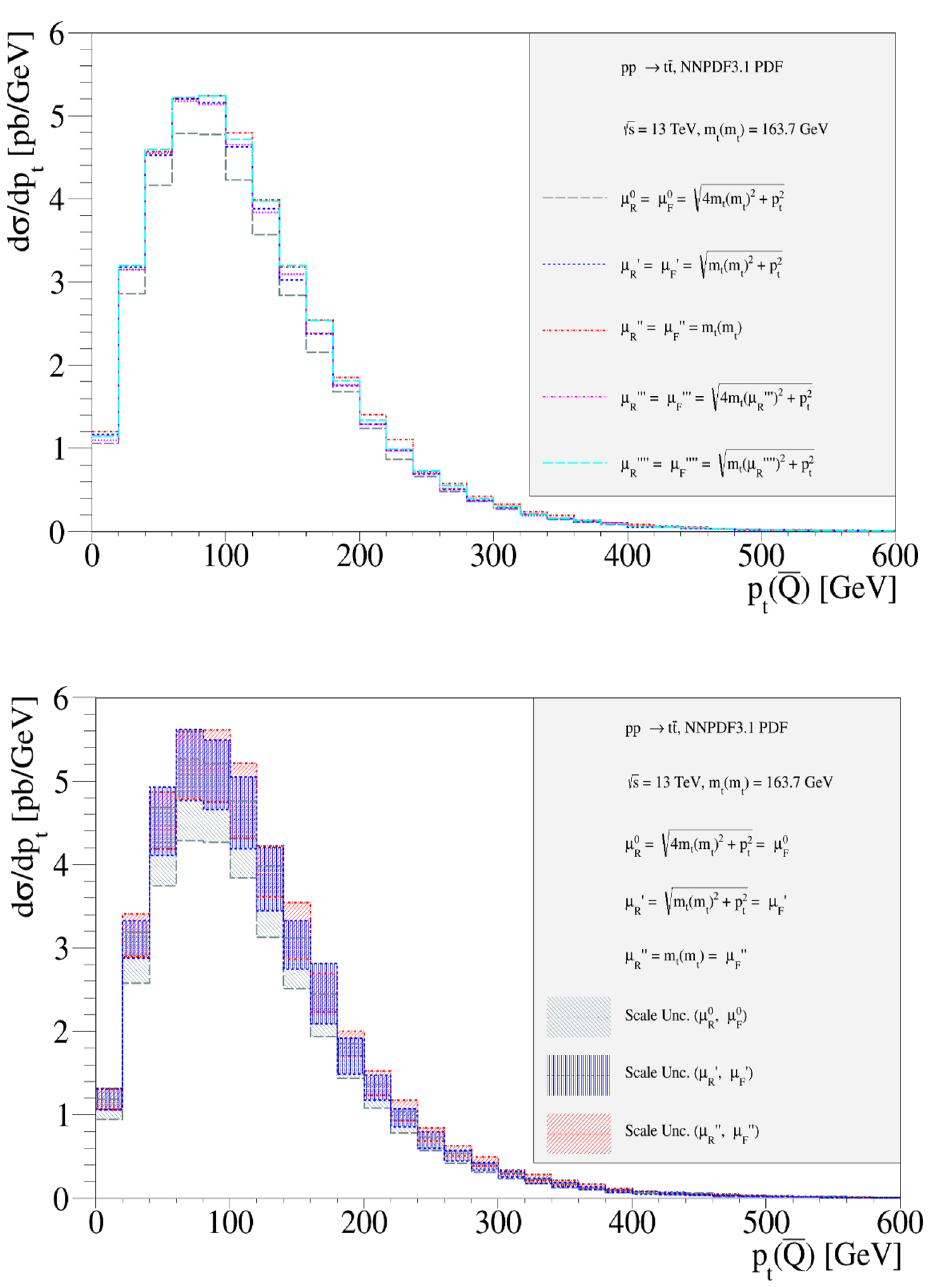
√ s = 13 TeV) for top hadro-production p p 2 + m 2 ( µ m ) and to t T p p 2 + 4 m 2 ( µ m ) for both µ m = m t ( m t ) and for µ m = µ R . t T